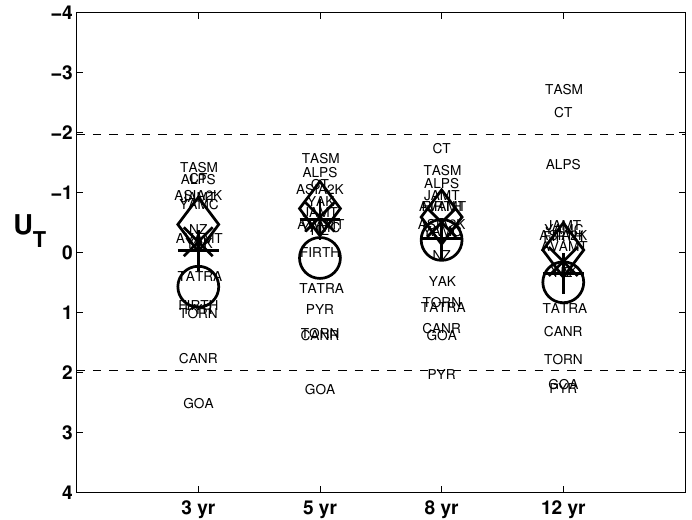
Figure 8. U T statistics comparing the multiple-forcing simulation ensembles with low and high solar forcing amplitude. Negative values (upwards) indicate where the high solar (E2) ensemble is closer than the low solar (E1) ensemble to the tree-ring-based observations. Symbols show results where all regions are combined with different c j weightings ( (cid:13) equal, series). Results are shown for four time units. Dashed lines show 5% significance levels for testing the null hypothesis that no simulation ensemble is closer to the observations than the